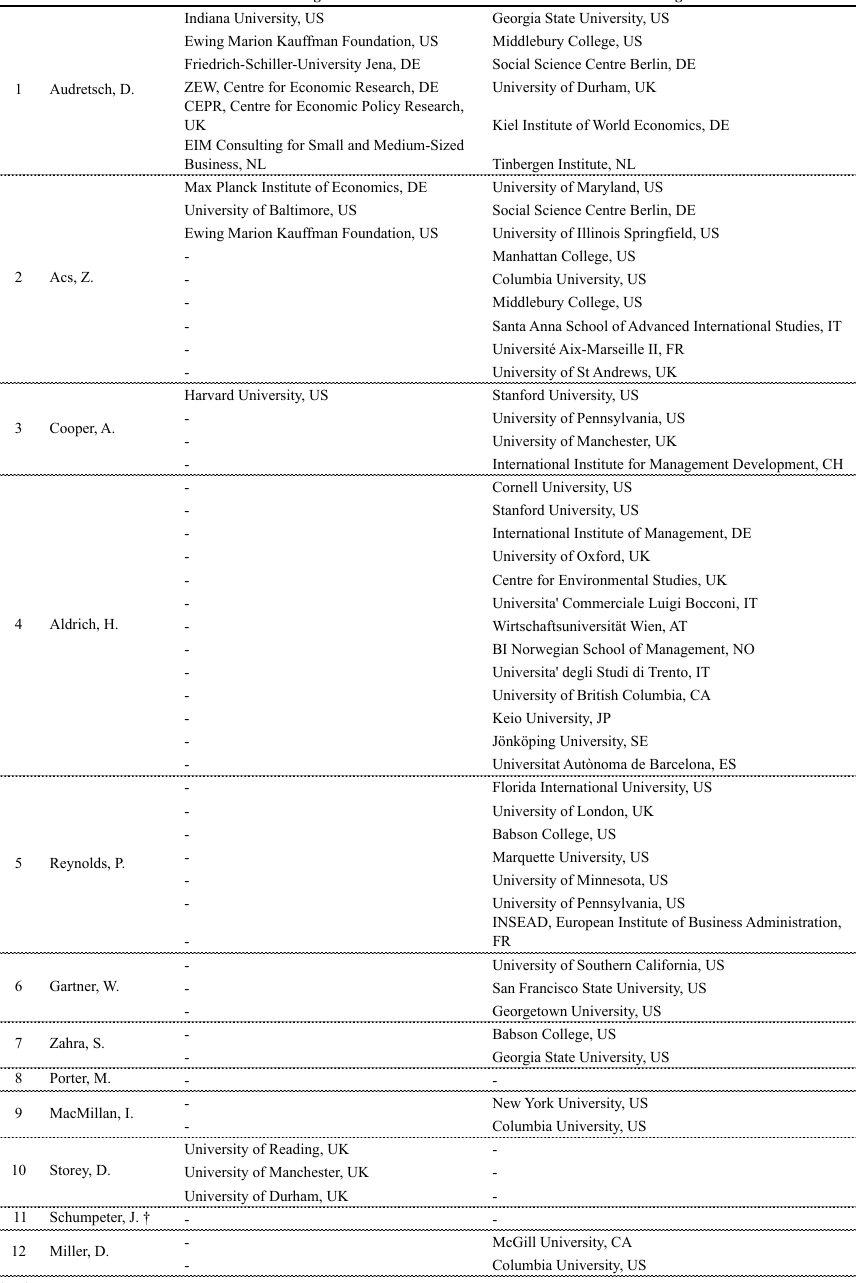
Table A3 : Information on current and previous professional affiliations/ visiting academic institutions of top authors